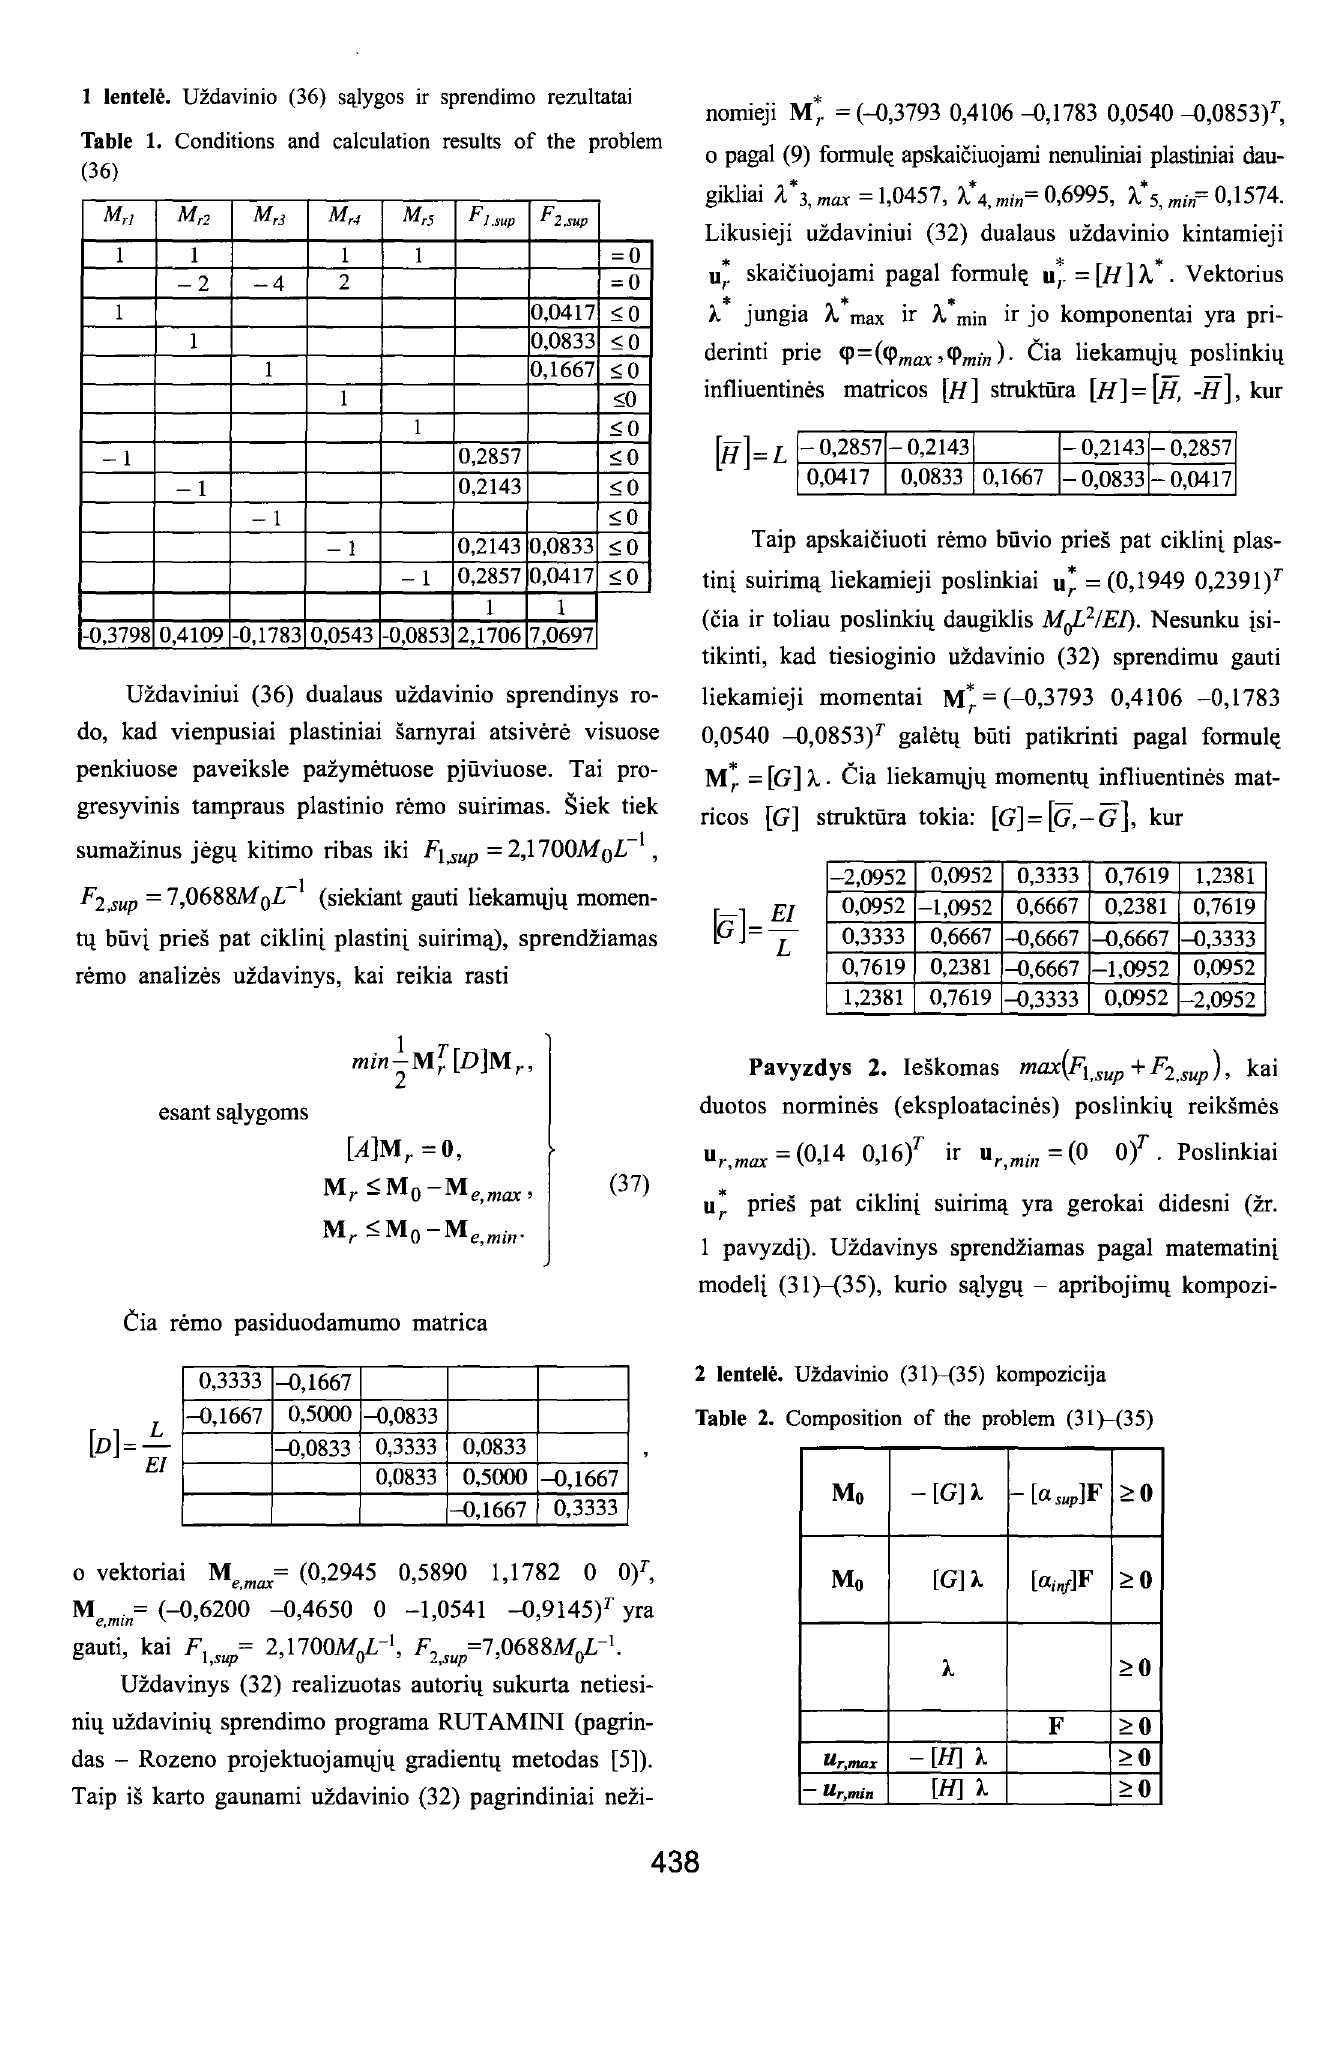
Table I. Conditions and calculation results of the problem (36)